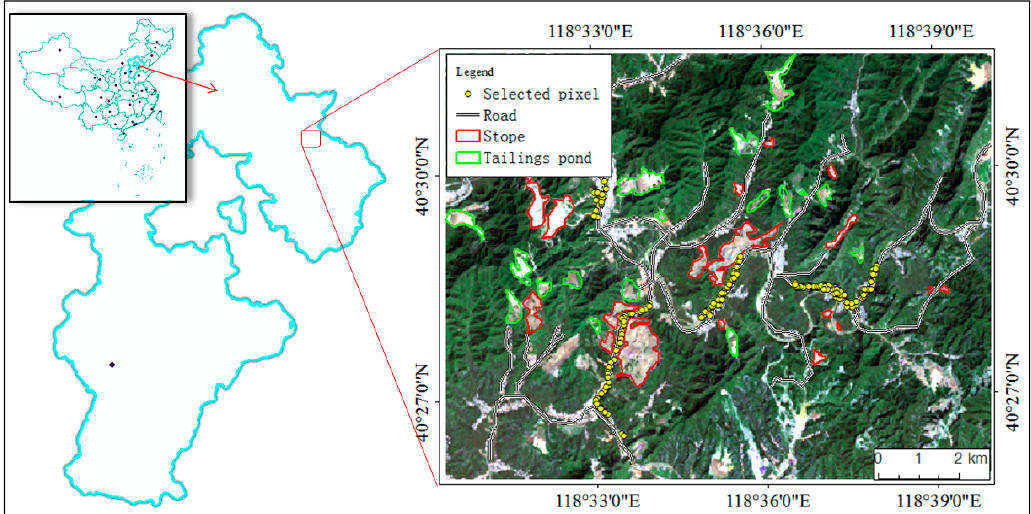
Figure 1. Location of Kuancheng Mining Area in a false-color composite image of Landsat 8 image (RGB432).